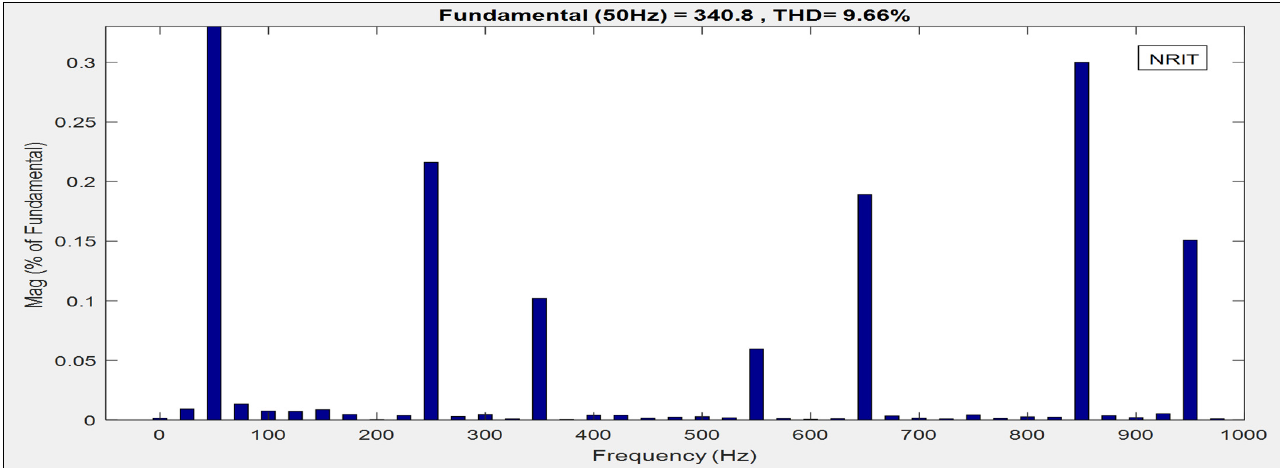
Figure 19. The THD case study 2 performance results with NRIT.